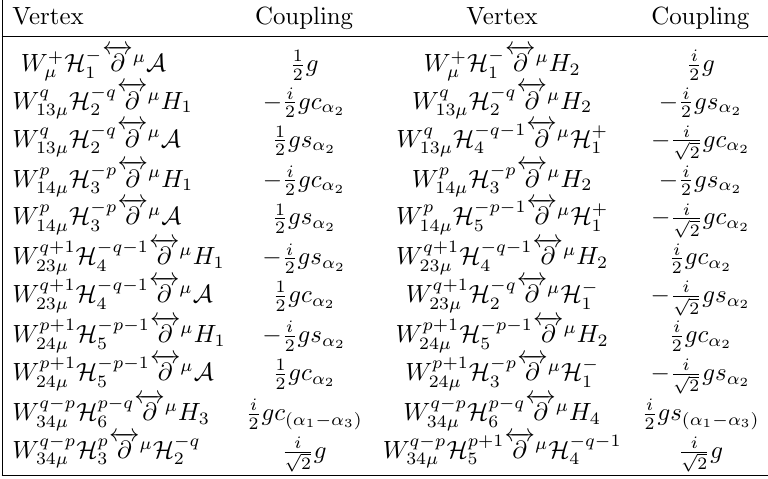
Table 7 . The interactions of a charged gauge boson with two scalars.